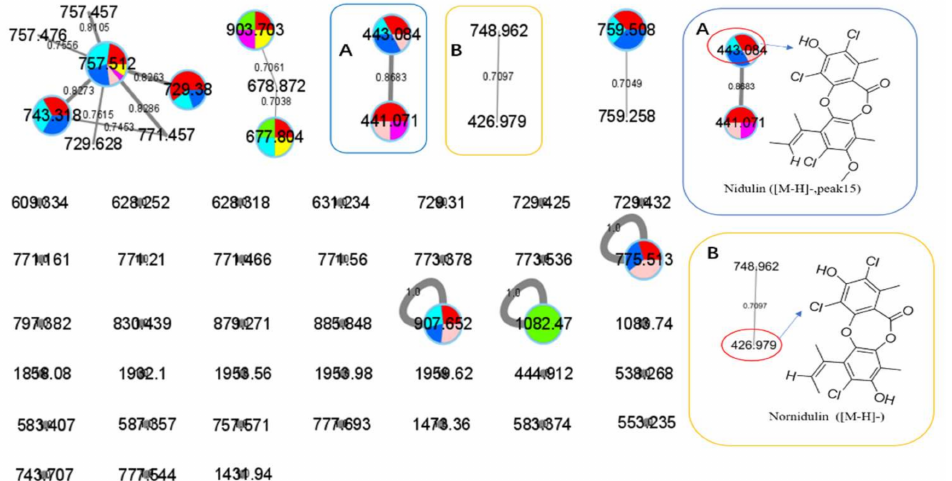
Figure 10. The GNPS molecular network based on negative ion MS/MS spectral similarity showing a selection of amplified clusters. The nodes display the measured average masses of the molecular ions with identical MS/MS spectra. The sizes of the nodes reflect the relative amount of the cor- responding compounds. The different colors of sections in the nodes represent different samples,